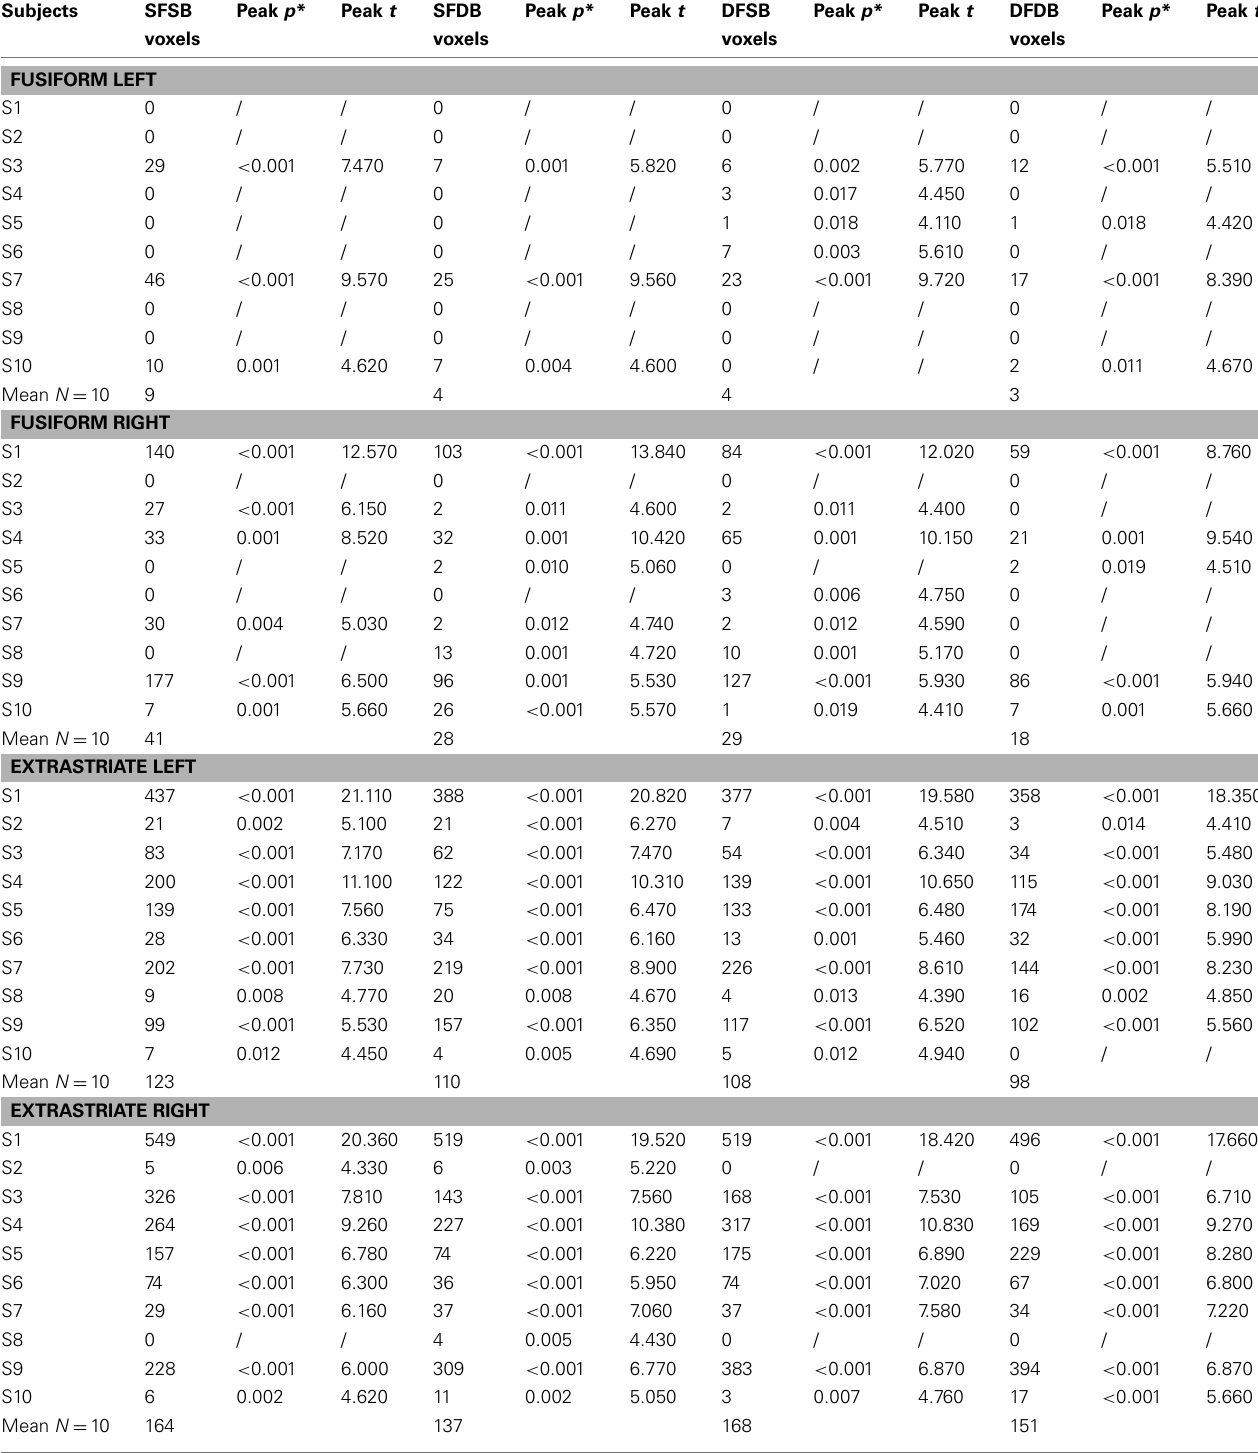
Table 1 |Adaptation effects: Individual